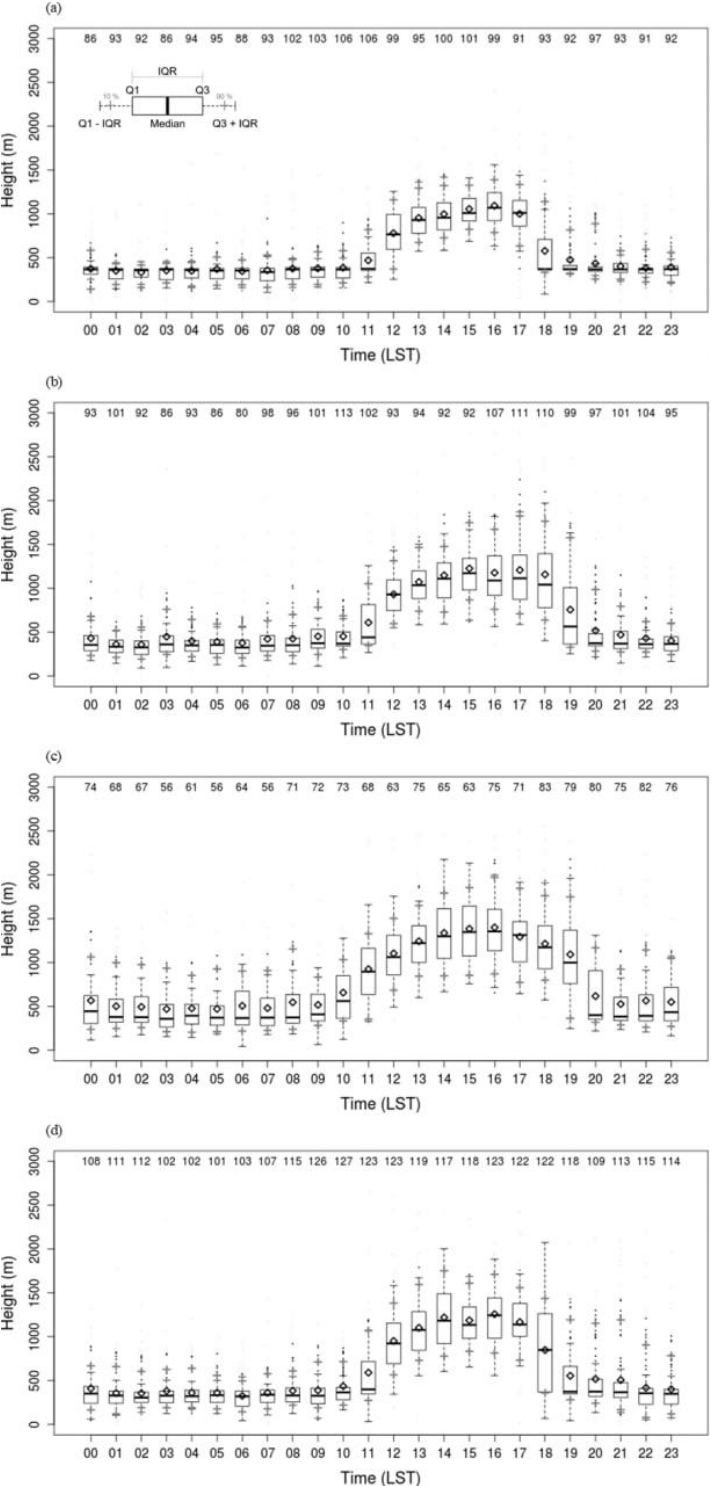
Figure 13. Box plots of hourly ABLHs for clear skies in (a) winter, (b) spring, (c) summer, and (d) autumn for the period from August 2016 to October